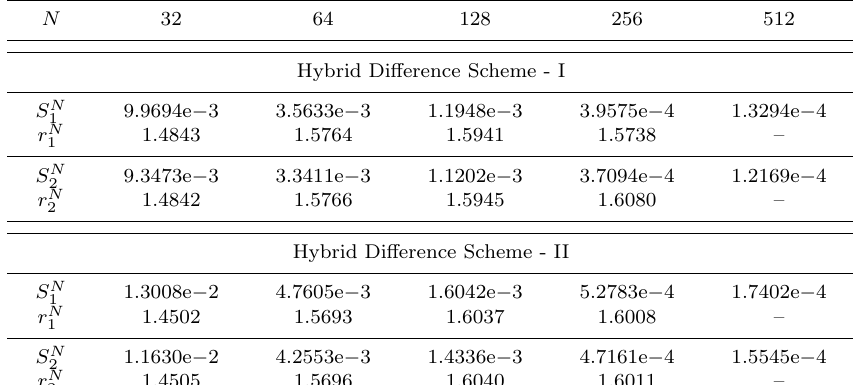
,r N and S N ,r N for the Example 1. 1 1 2 2